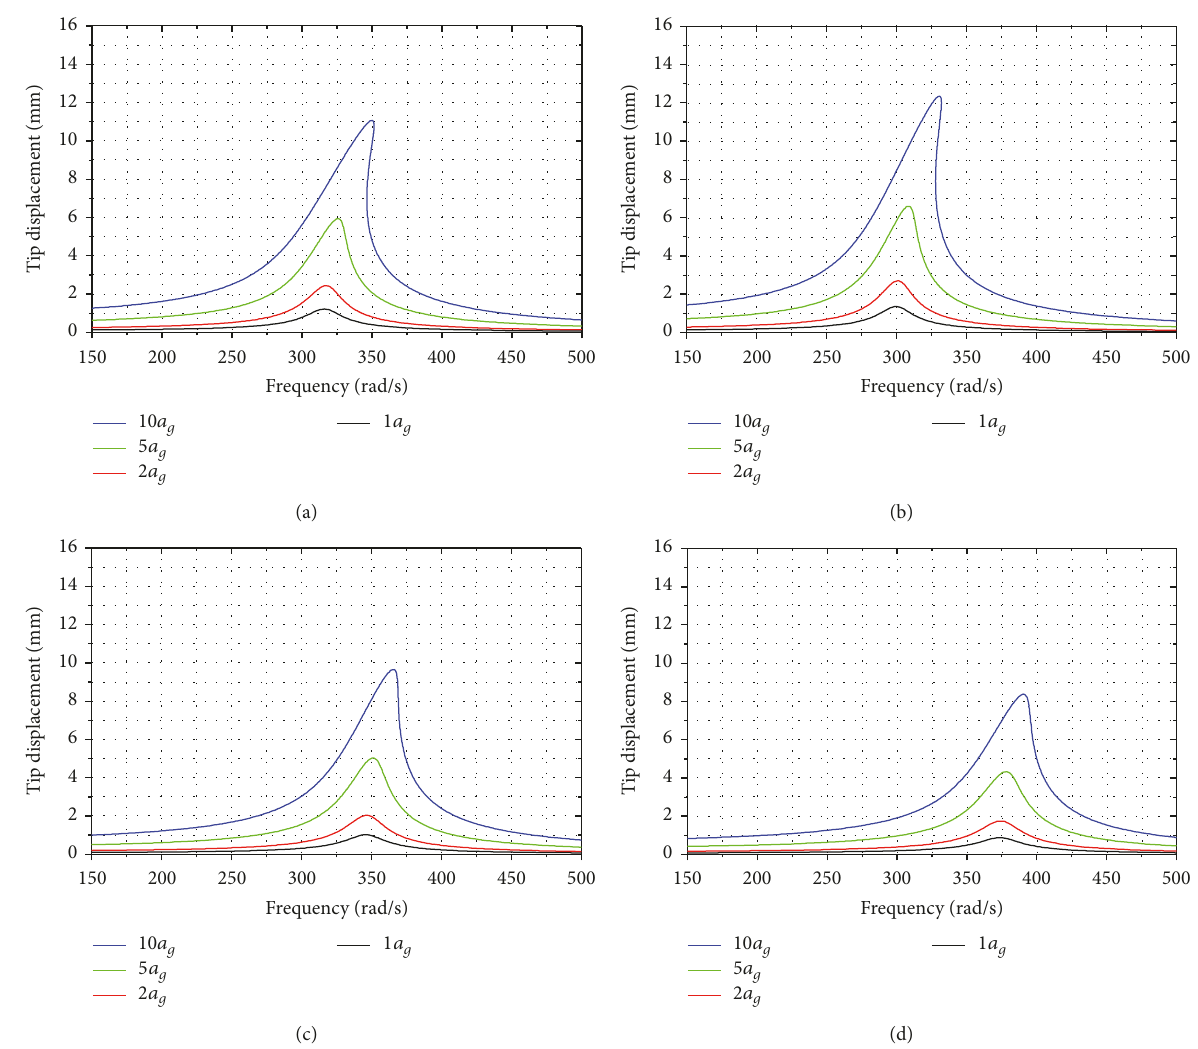
Figure 13: FRFs of the maximum tip displacement for base acceleration amplitudes ranging from 1 𝑎 𝑔 to 10 𝑎 𝑔 , where (a) 𝑇 PVDF = 𝑇 0 PVDF , (b) 𝑇 = 0.5𝑇 0 𝑇 = 1.2𝑇 0 𝑇 = 1.4𝑇 0 PVDF PVDF PVDF PVDF , (c) PVDF PVDF , and (d)